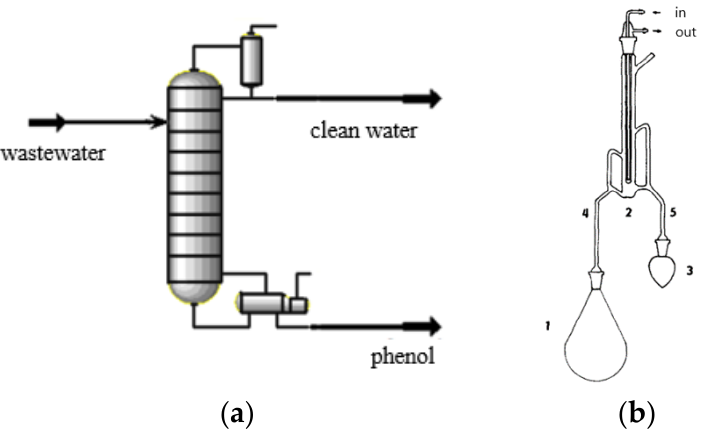
Figure 6. Schematic of ( a ) distillation column, ( b ) micro-apparatus for continuous steam distillation- extraction Adapted from Ref. [27]. Copyright 1984 Elsevier.